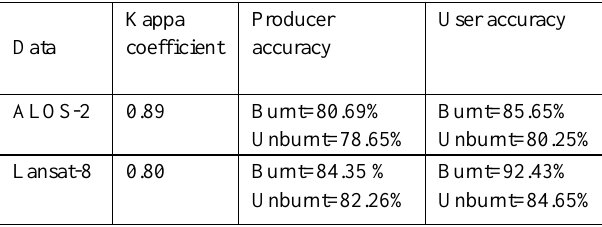
Table 2. Accuracy assessment results based on kappa statistics from SVM classification of SAR and optical over the AOI.